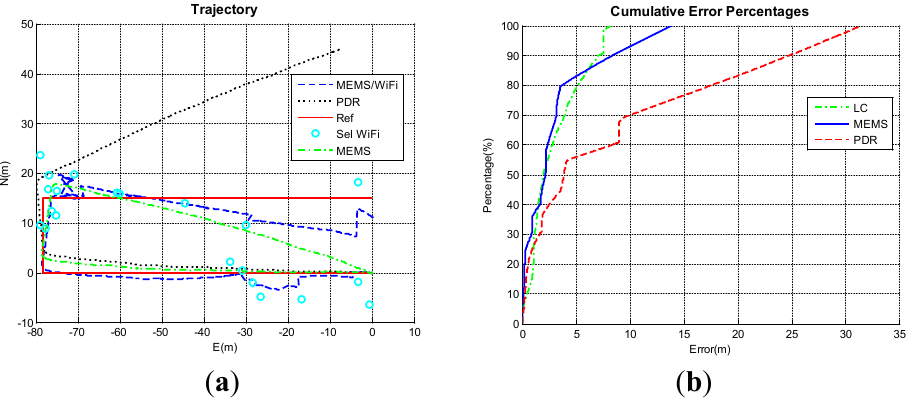
Figure 9. Trilateration-based WiFi positioning solution. ( a ) WiFi trajectory; ( b ) Variances of WiFi positions.